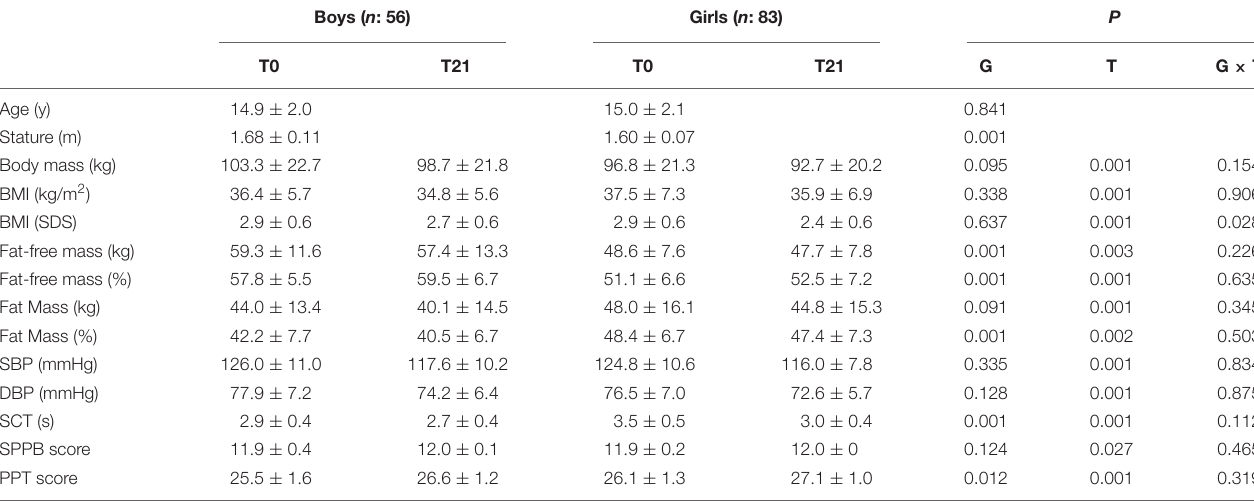
TABLE 1 | Physical characteristics of adolescents with obesity before (T0) and after (T21) the 3-week BWRP. Boys ( n : 56) Girls ( n : 83)